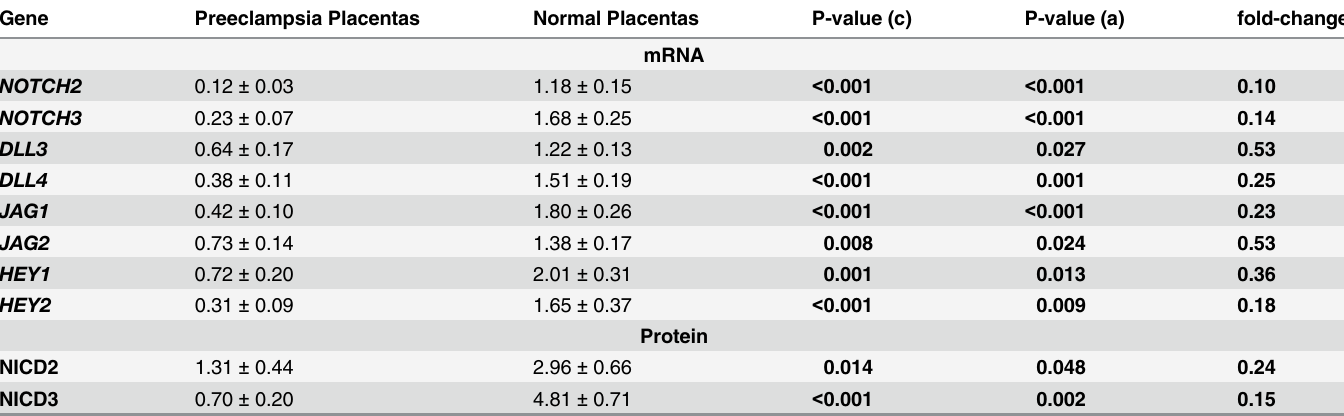
Table 3. Expression analysis of Notch signaling pathway between normal and PE placentas.